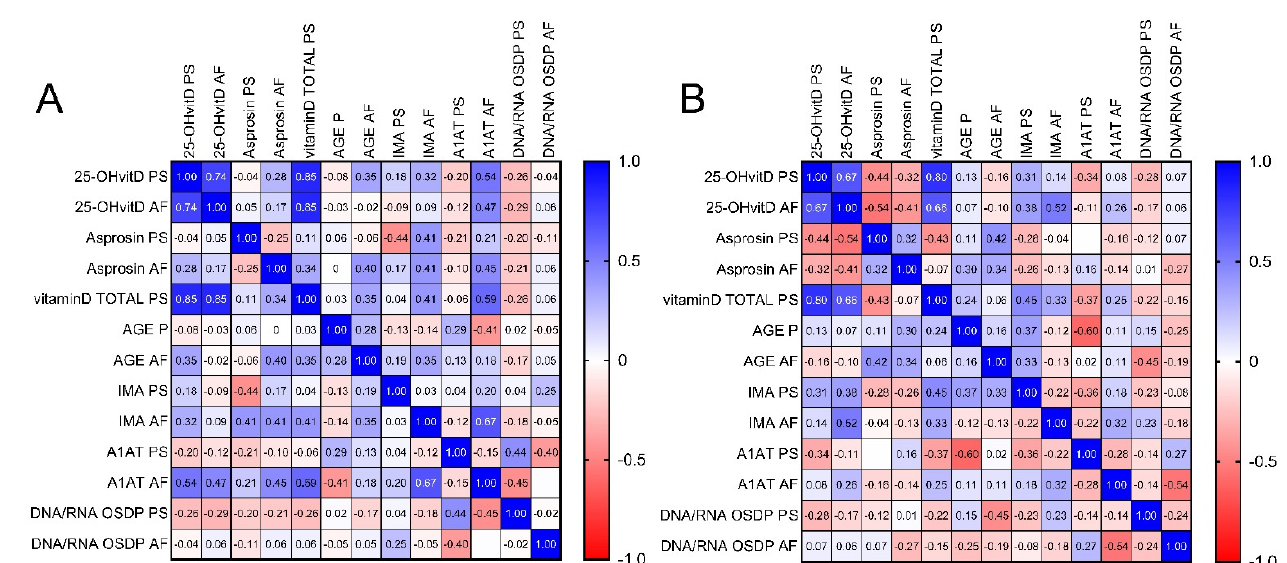
Figure 2. Graphical Spearman correlation matrix of the biochemical parameters in ( A ) the control group and ( B ) the study group. A1AT, alfa-1-antitrypsin; AF, amniotic fluid; AGE, advanced glycation end products; IMA, ischemia-modified albumin; OSDP, oxidative stress damage product; PS, plasma; Vit D, vitamin D.